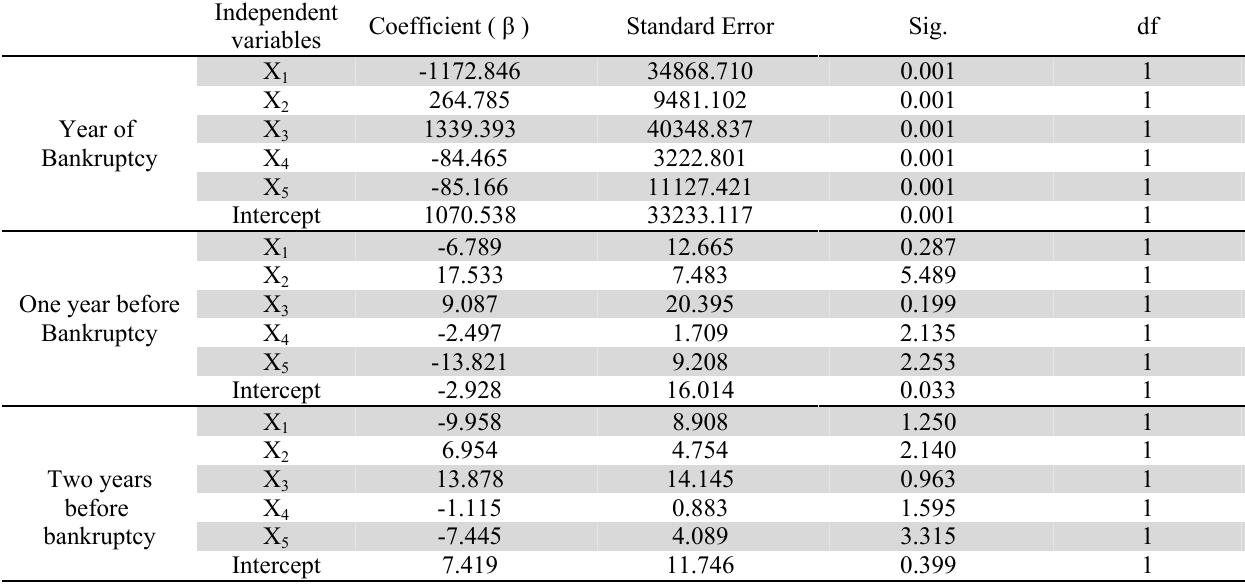
The summary of regression analysis